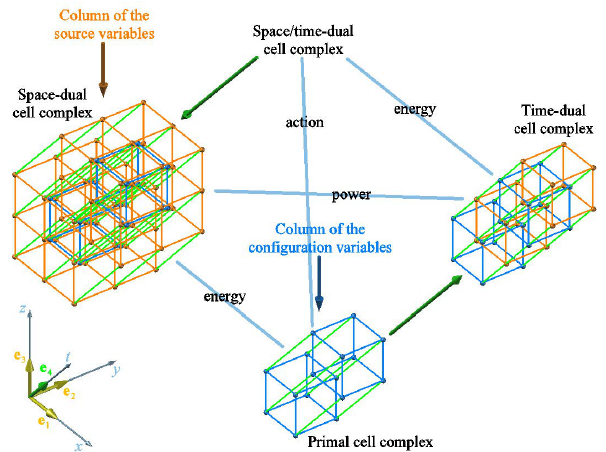
Figure 12: Primal and dual cell complexes in